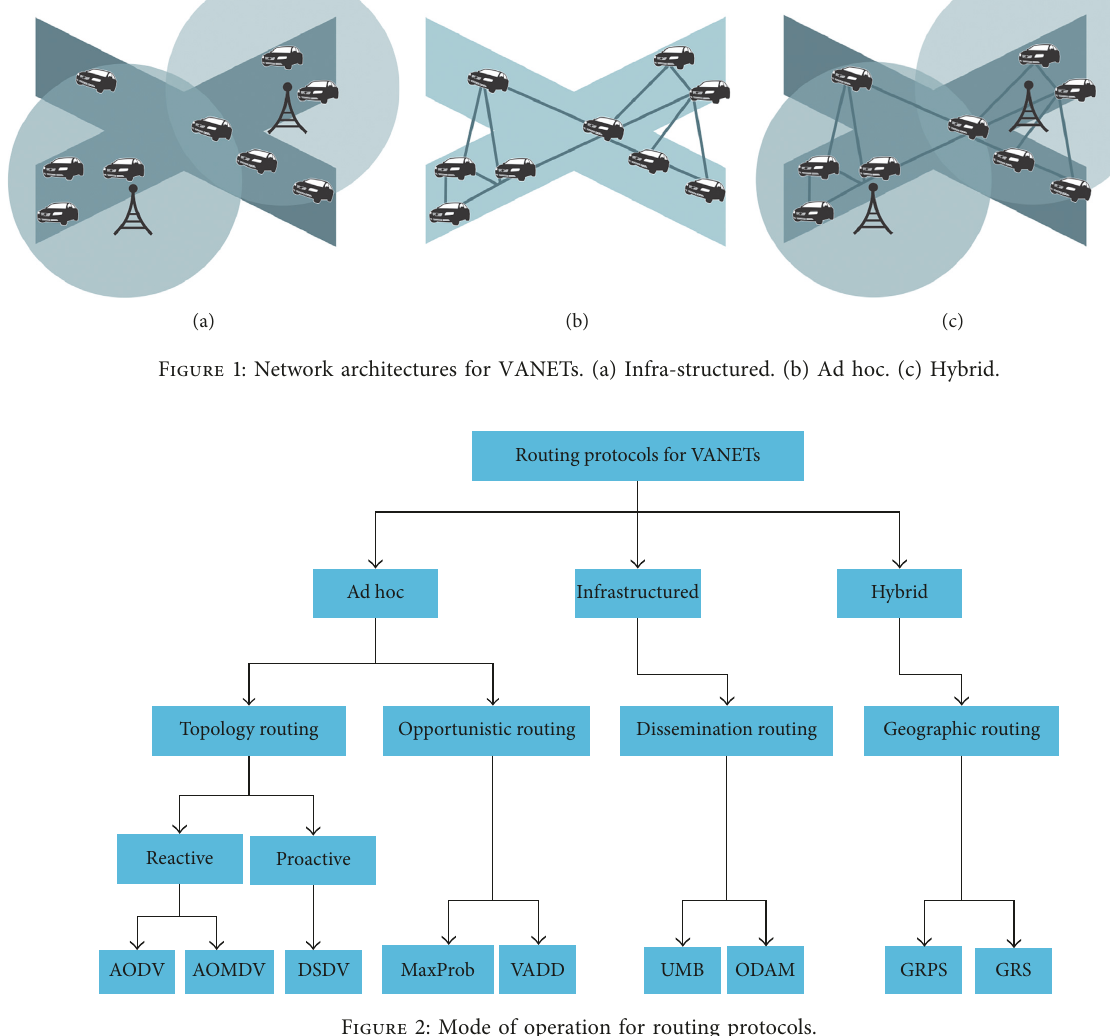
Figure 2: Mode of operation for routing